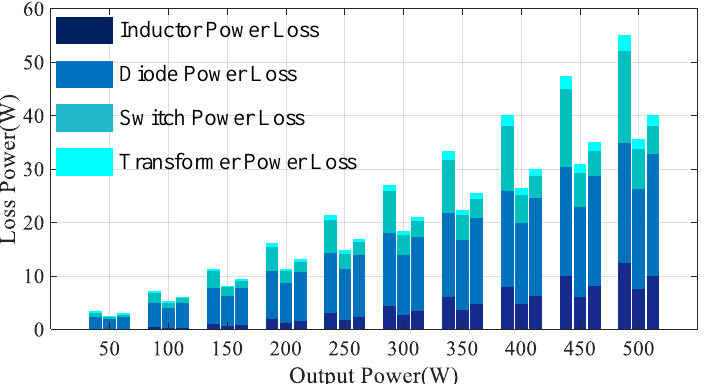
Figure 8. Power Loss Comparison: Left bar) Full power QZSC, Middle bar) Basic PPP QZSC, Right bar) Proposed PPP QZSC .